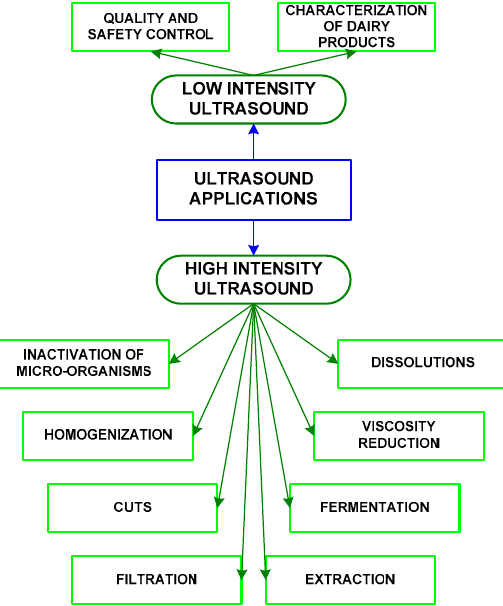
Figure 11. Applications of low-intensity and high-intensity ultrasounds.